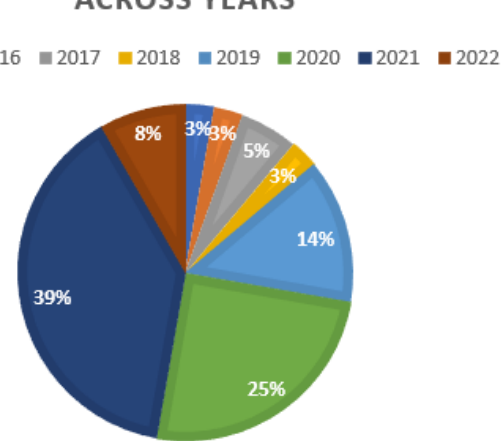
Figure 4. Distribution of articles on the use of satellite data with deep learning between 2015 and